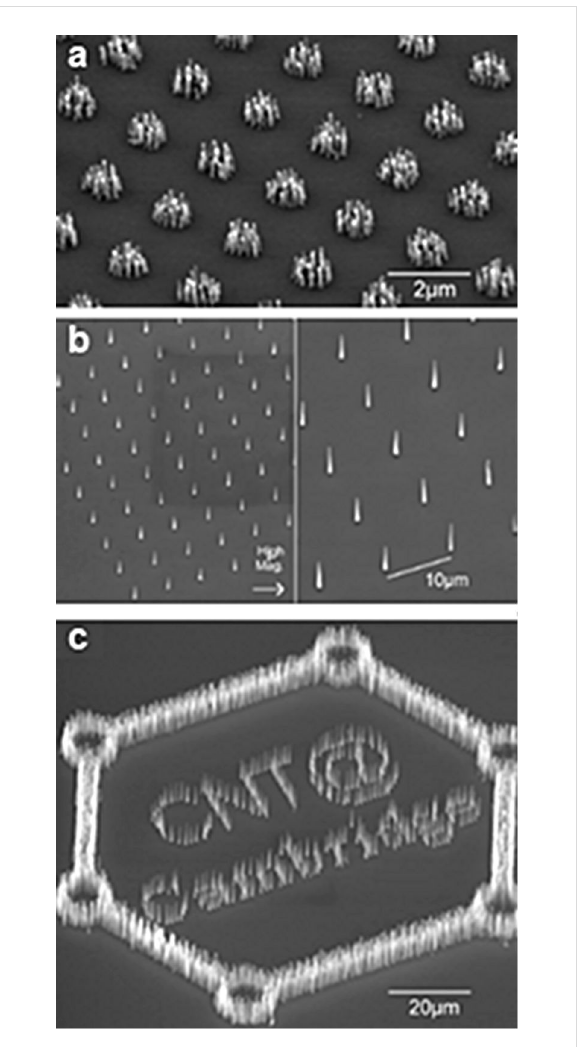
Figure 4: Various examples of nanotube arrays grown on Ni dots. (a) Bunches of nanotubes (about 100 nm in diameter) are deposited on 1 µm nickel dots, because the nickel catalyst film breaks up into nanoparticles. (b) Single nanotubes will grow when the size of the Ni dot is reduced to 100 nm, as only a single nanoparticle is formed from such a dot. (c) Demonstration of high yield, uniform, and selective growth of nanotubes at different densities. Adapted with permission from [63]. Copyright 2001 American Institute of Physics.